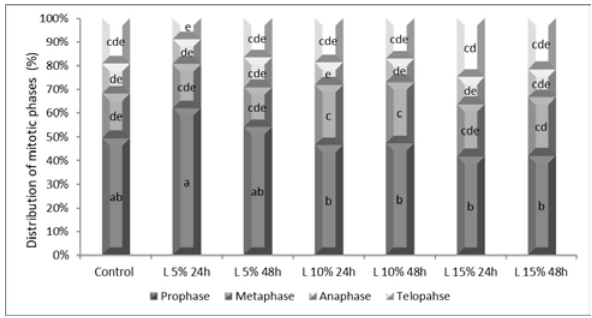
Figure 3. The influence of L. sibirica extracts on the distribution of mitotic division phases in the radicular meristem cells of A. cepa L. (the data are ± SE averages of three repetitions; a, b, c, d, e, f, g, h, i, j, k – the interpretation of statistical significance and of significant differences through the Duncan test, p